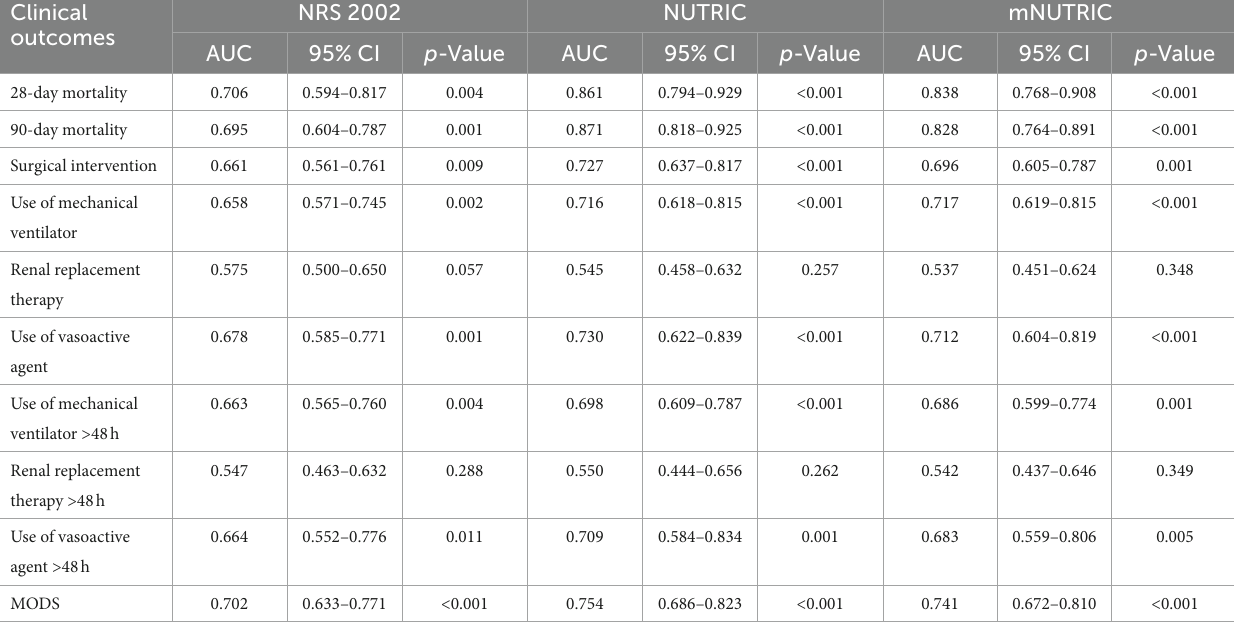
TABLE 2 Prognostic accuracy of the NRS2002, NUTRIC, and mNUTRIC to predict clinical outcomes analyzed by ROC. Clinical